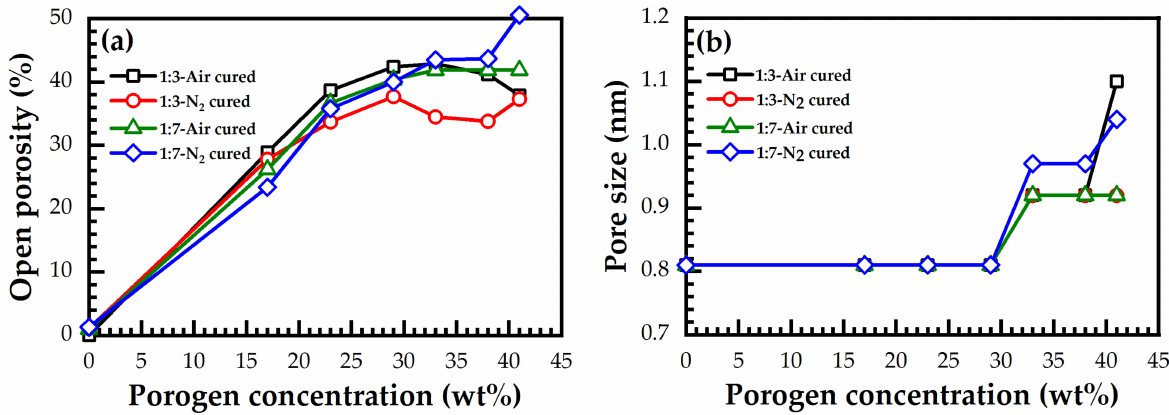
Figure 13. ( a ) Open porosity and ( b ) pore size versus porogen concentration for 1:3 and 1:7 materials, after being cured at 400 ◦ C in the air for 30 min (air-cured), and in N 2 for 60 min (N 2